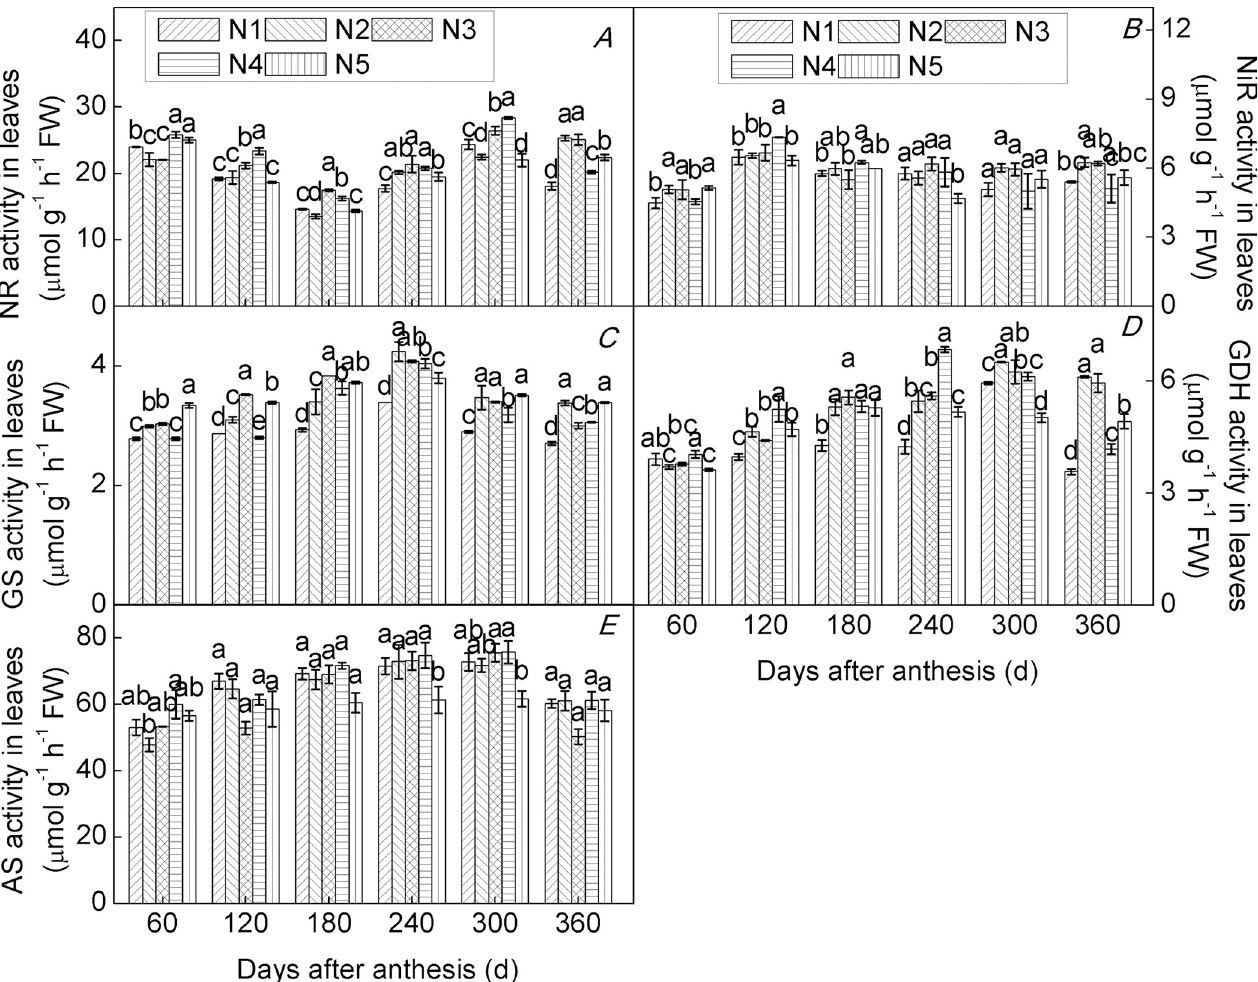
Fig 7. Relative enzyme activity in leaves of the citrus cultivar ‘Huangguogan’. NR (Nitrate reductase, A), NiR (nitrite reductase, B), GS (glutamine synthetase, C), GDH (glutamate dehydrogenase, D) and AS (asparagine synthetase, E). N 1 : 0, N 2 : 1.36, N 3 : 1.81, N 4 : 2.26, N 5 : 2.72 kg N/ year [CO(NH 2 ) 2 , N �